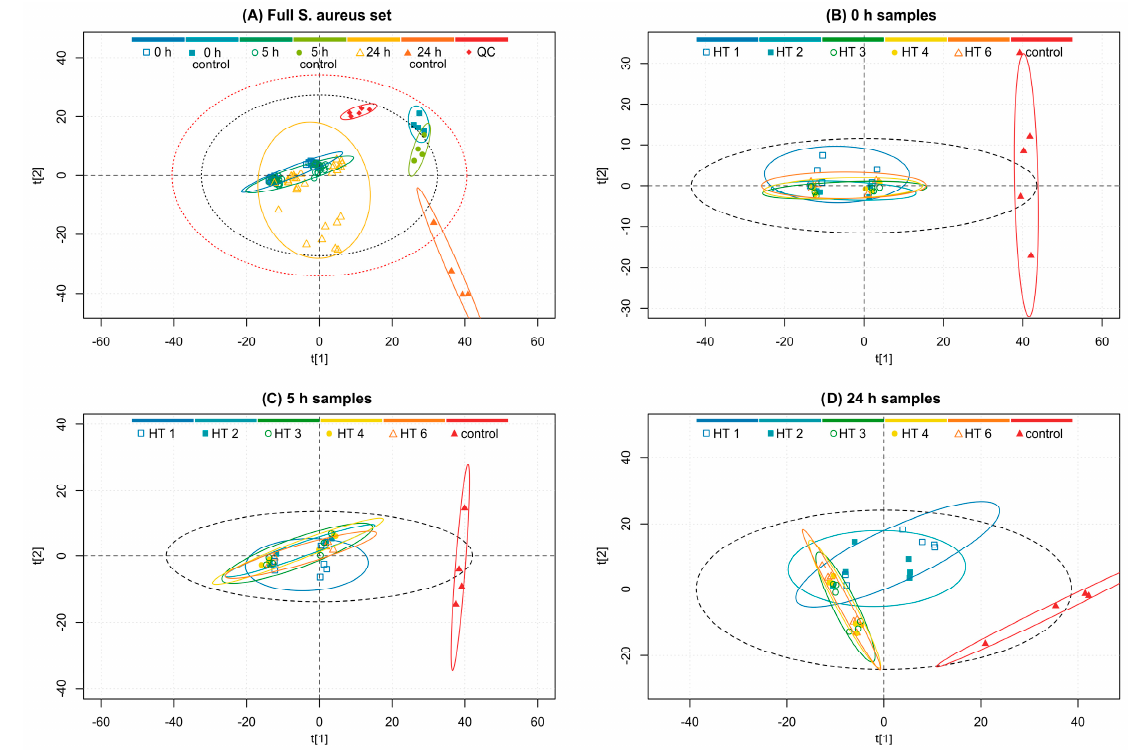
Metabolites 2023 , 13 , x FOR PEER REVIEW 8 of 25 Figure 5. PCA model score plots of the ( A ) full S. aureus sample set (R2X(1) = 0.38, R2Y(2) = 0.18), ( B ) samples at the 0 h time point (R2X(1) = 0.58, R2Y(2) = 0.05), ( C ) samples at the 5 h time point (R2X(1) = 0.55, R2Y(2) = 0.20), and ( D ) samples at the 24 h time point (R2X(1) = 0.47, R2Y(2) = 0.19) with hydrolyzable tannins (HTs). Plot ( A ) groups according to the time point, time point control, or quality control (QC), and plots ( B – D ) groups according to the HT treatment or control. Red and grey ellipses show Hotelling’s T2 99% and 95% confidence intervals, respectively, and group ellipses show 95% confidence intervals. ( A ) 0 h samples ( □ , dark blue), 0 h controls ( ■ , turquoise), 5 h samples ( ⚪ , dark green), 5 h controls ( ⚫ , light green), 24 h samples ( △ , yellow), 24 h controls ( ▲ , orange), and quality control samples ( ♦ , red). ( B – D ) HT 1, strictinin ( □ , blue); HT 2, castalagin ( ■ , turquoise); HT 3, tellimagrandin II ( ⚪ , dark green); HT 4, pentagalloylglucose ( ⚫ , yellow); HT 6, rugosin D ( △ , orange); and controls ( ▲ , red).